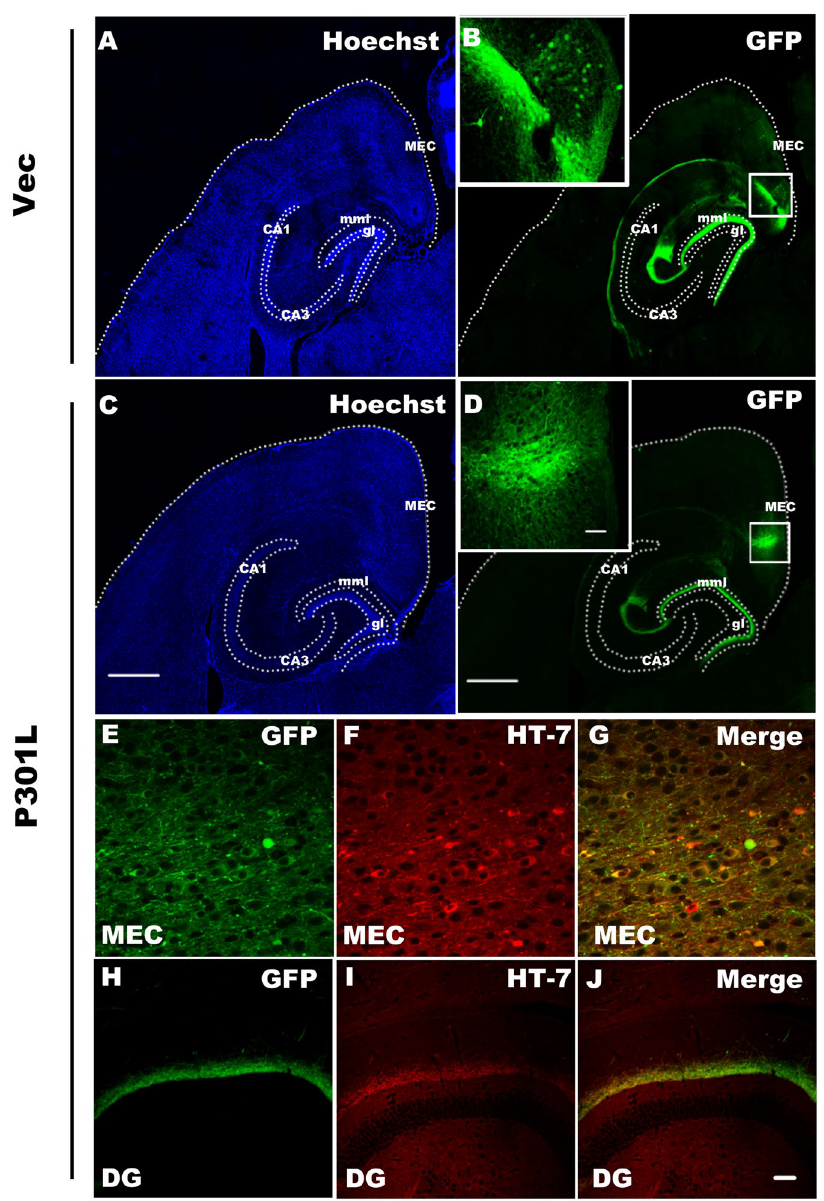
Figure 1. rAAV vehicles drives gene expression in the medial entorhinal cortex (MEC). Low-magnification view of a horizontal section of mouse brain stained with hoechst (( A ) vector; ( C ) P301L) and GFP autofluorescence showing a restriction of target protein expression in MEC and its projection fibers to the middle molecular layer (mml) of hippocampal dentate gyrus (DG) (( B ) vector; ( D ) P301L, arrows point cell bodies) one month after transduction via rAAV delivery, while no GFP was observed in the granular layer (gl) of the dentate gyrus, which is outlined with a white dotted line (scale bar, 500 μ m). The insets in ( B , D ) show the high magnification of MEC (scale bar, 50 μ m). HT-7 was employed to detect human tau in the present study. The results showed a co-localization of HT-7 with GFP in the neuronal cell bodies and fibers of MEC ( E – G ), and the projection fibers to DG region ( H – J ). (scale bar in ( A – D ) 500 μ m; in insets of ( B , D ) 50 μ m; in E-J, 50 μ